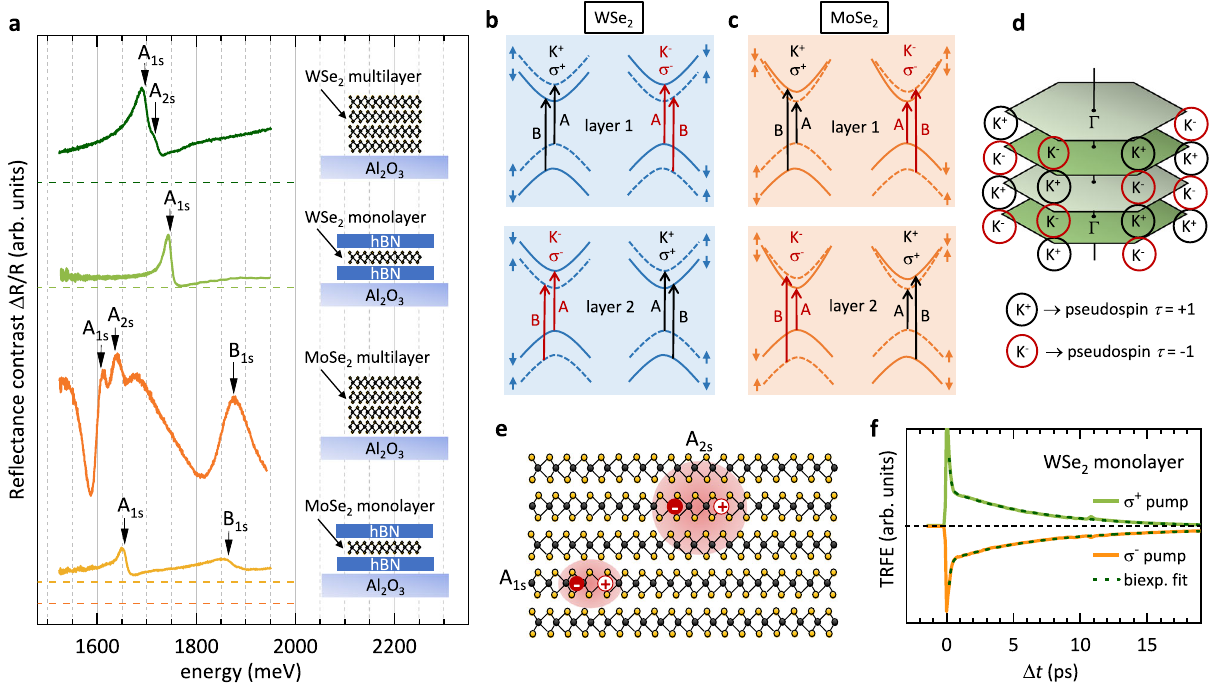
Fig. 1 | Re fl ectance-contrast and TRFE experiments,intralayer transitions, and pseudospin-layer locking. a White-light re fl ectance-contrast experiments of the investigated samples: MoSe 2 and WSe 2 monolayers, encapsulated in hBN, and multilayer samples of both materials. The corresponding zero lines are given as dashed lines of the same color. All samples are prepared on transparent sapphire substrates.ThesubstratetemperatureinallRCmeasurementswas T ~20K,except for the MoSe 2 multilayer, whereitwas<10 K,as derived from the intensity ratioof ruby lines from the substrate (see methods section). Excitonic transitions, as derived from atransfer-matrix-model fi t,areindicated bysmallverticalarrows.We note thattheTRFEexperimentsare allperformed at T ~5 K. b Schematicpictureof